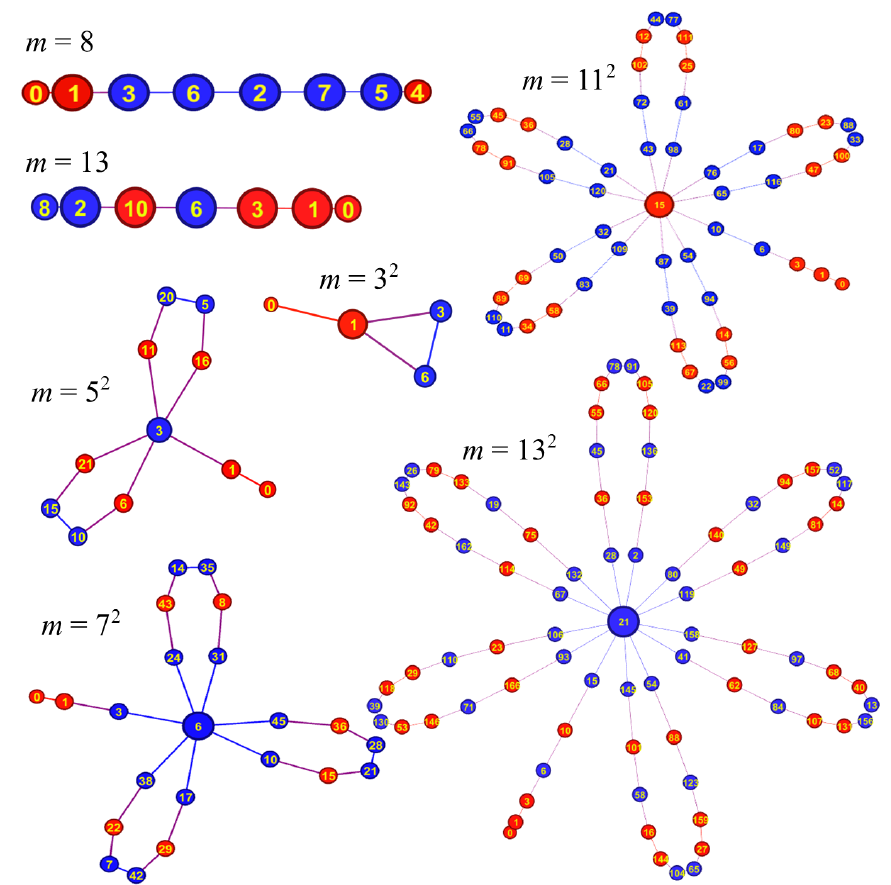
Figure 10. Several examples of graph representations of T m . All powers of two are linear path graphs of size m . Likewise, all primes are linear path graphs of size m + 1 . Prime squares are “flower” graphs 2 with m − 1 petals and one stem. The stem has m − 1 vertices made up of m − 1 vertices. Finally, there is 2 2 one central vertex called the ultimate vertex which is of degree m . The base of the stem is of degree one; all remaining vertices are of degree two. The graphs are colored according to whether a vertex represents a perfect square (red) or a nonsquare